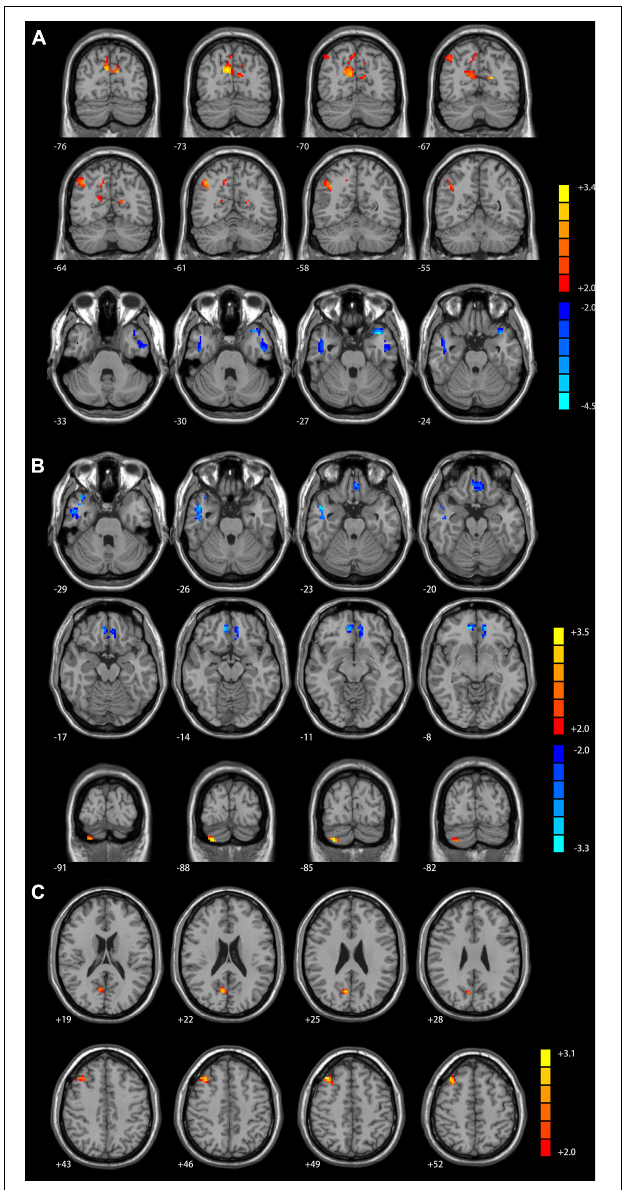
FIGURE 2 | Cerebellar connectivity differences between major depressive disorder (MDD) patients with GI symptoms and healthy controls [ (A) seed left Crus I; (B) seed right Crus I; (C) seed lobule IX]. The color bar indicates the T values. Results were GRF corrected. GI, gastrointestinal symptoms; GRF, Gaussian random field